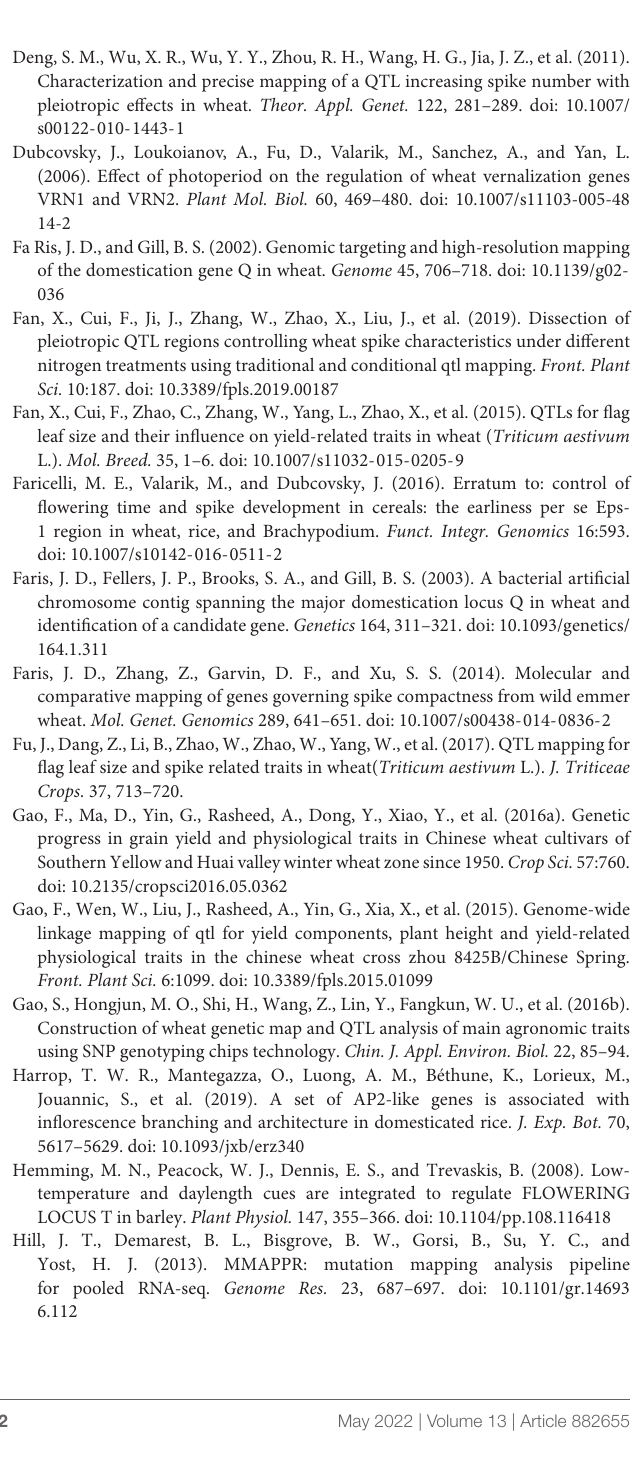
Supplementary Figure 1 | Expression pattern of genes within the QSc/Sl.cib-2AL interval. Expression data originated from the WheatOmics GeneExpression (http://202.194.139.32/expression/index.html). A, B, C, D, and E (A,B) represent root, stem, leaf, grain, and spike,